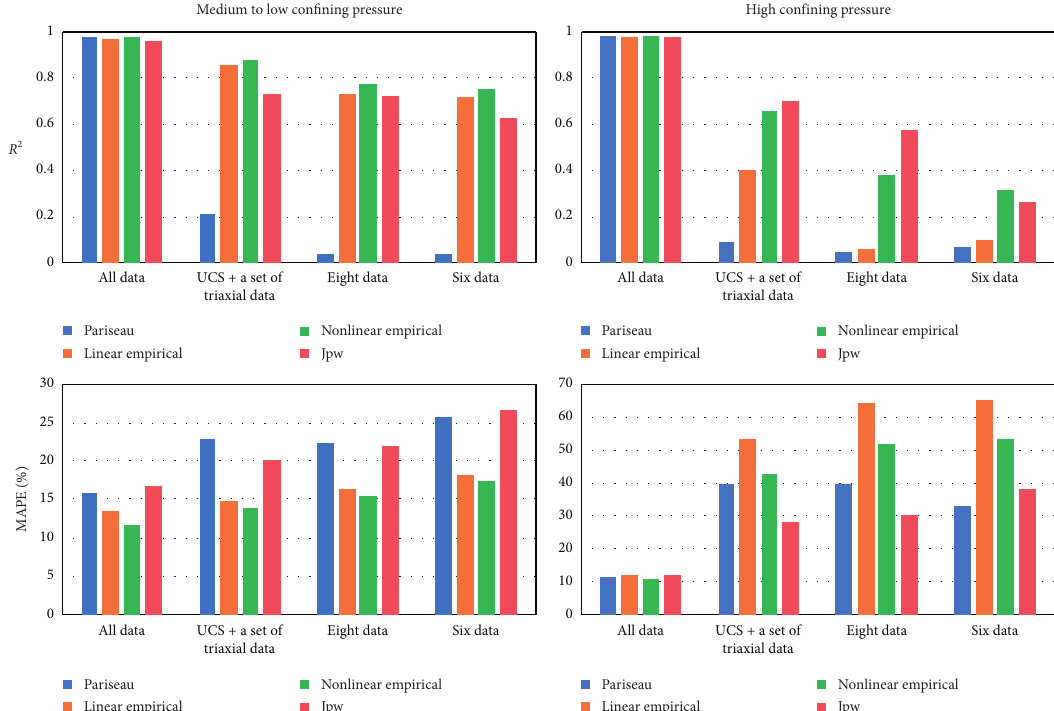
Figure 9: The R2 and MPAE of all criteria under different